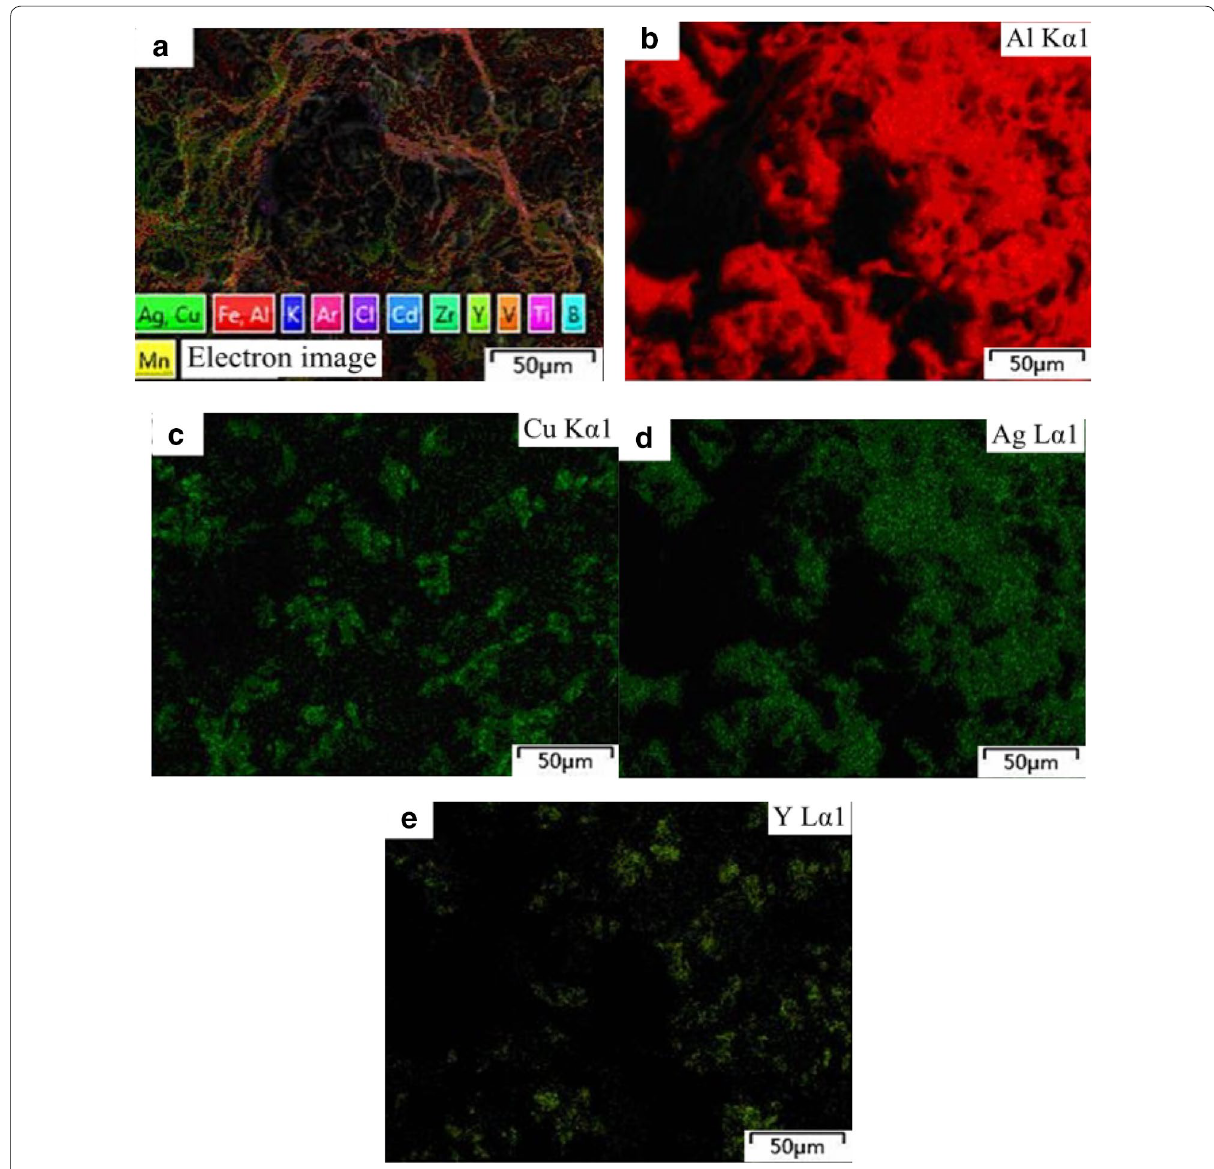
Figure 7 a EDS images of alloy, b – e element